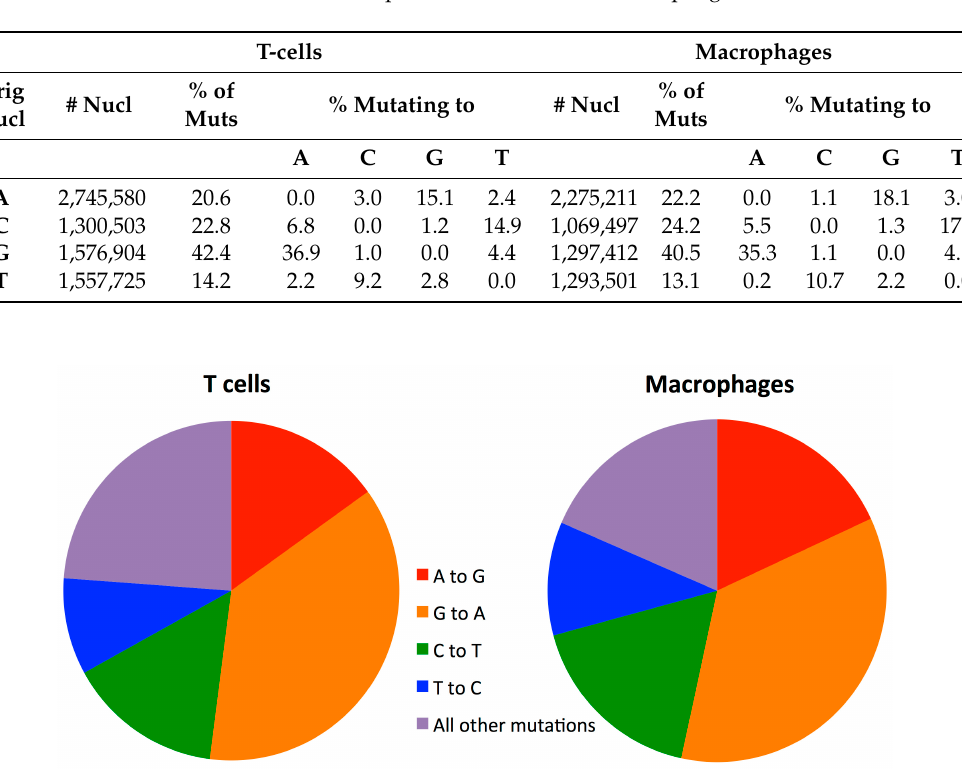
Figure 4. Pie charts showing patterns of mutations in T ‐ cells and macrophages. Specific transitions are shown as they represent the highest rates of mutation.